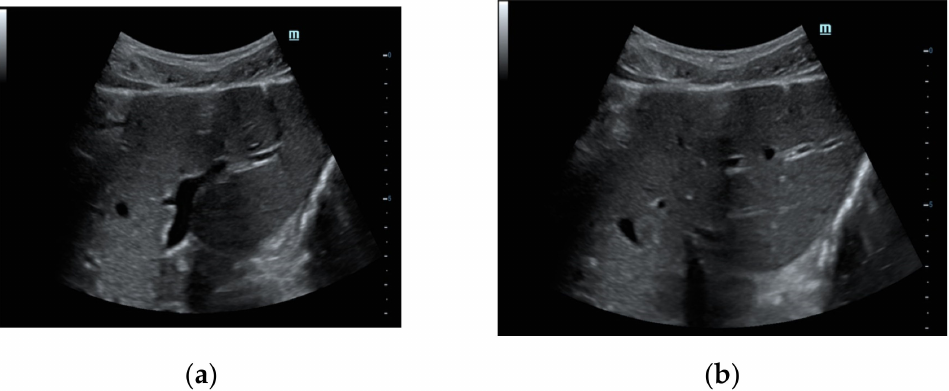
Figure 2. Female patient, 37 years old with E.R. access for acute abdomen and successive surgical confirmation of GI perforation. ( a ) Transverse midline US abdomen scans in B-mode show typical artefacts related to free bubble gas presence as bright and highly echogenic lines with distal rever- beration and shadowing artifacts (comet-tail artifacts), especially in the pre-hepatic plane. ( b ) The detection of free air is typically found by looking under the anterior abdominal wall, considering the free air bubble’s tendency to be placed